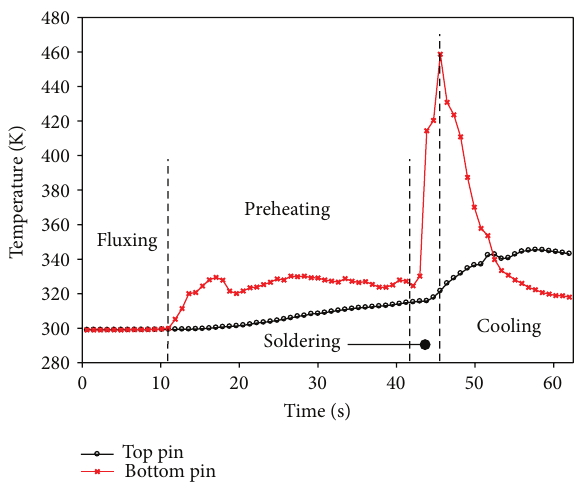
Figure 7: Temperature profiles at different zones.